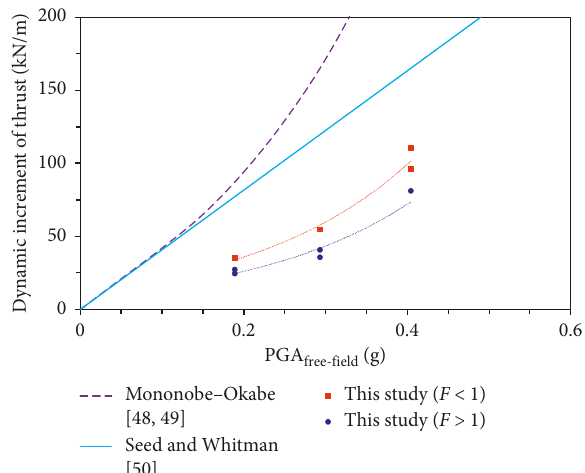
Figure 14: Comparison of computed dynamic increment of thrust with available analytical solution.